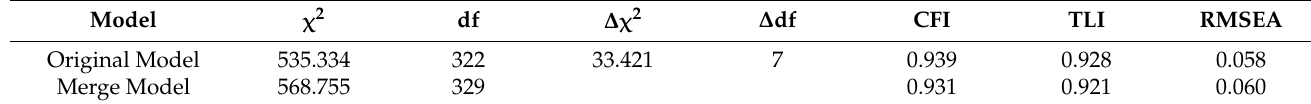
Table 5. Discriminant analysis